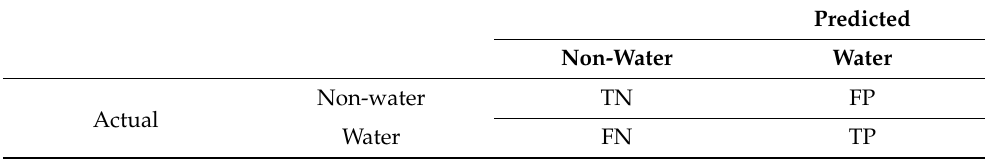
Table 1. Confusion matrix used for binary